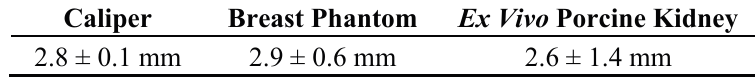
Table 1. Distance between the PZT actuator and the tip of the biopsy